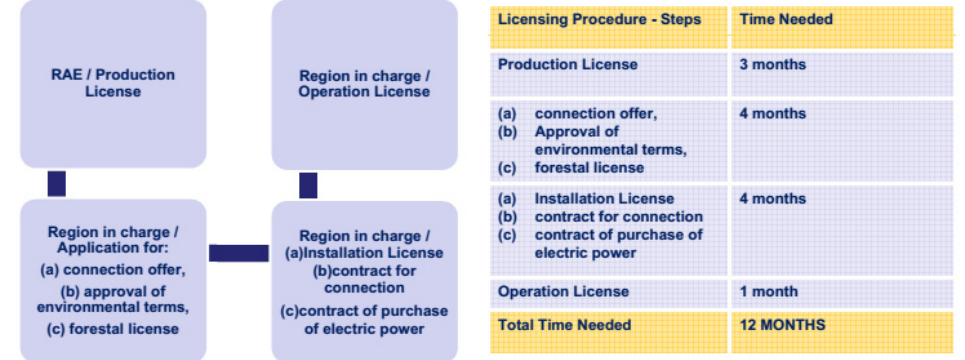
Figure 1. The licensing procedure for electricity generation from renewable energy sources (RES-E) projects in Greece (Source: [19]).RAE, Regulatory Authority of Energy.